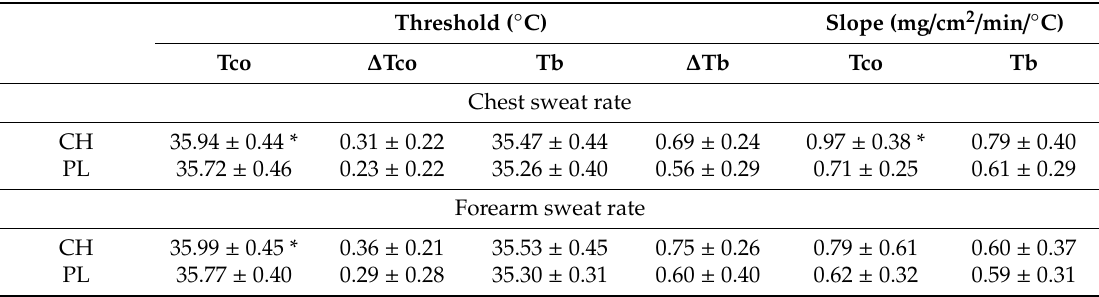
Table 4. Body core temperature and mean body temperature thresholds and slopes for sweating in the main experiment.